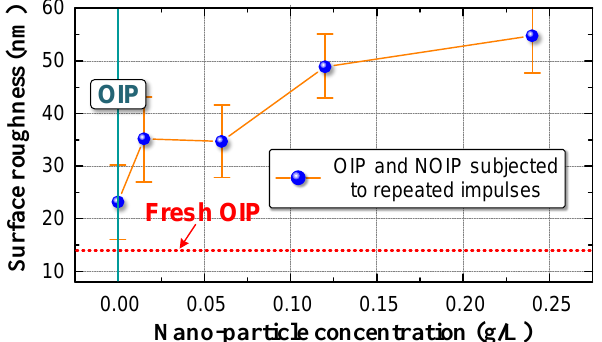
Figure 18. Relation between surface roughness and nanoparticle concentration.